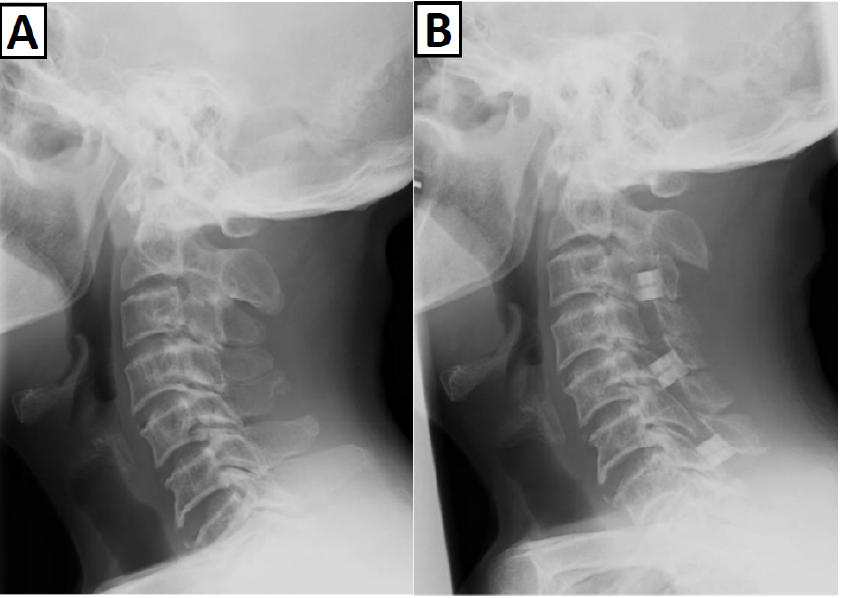
Figure 1. Cervical X-rays of the patient before ( A ) and after ( B ) vertebral resection for OPLL. After the operation, her symptoms partially improved.